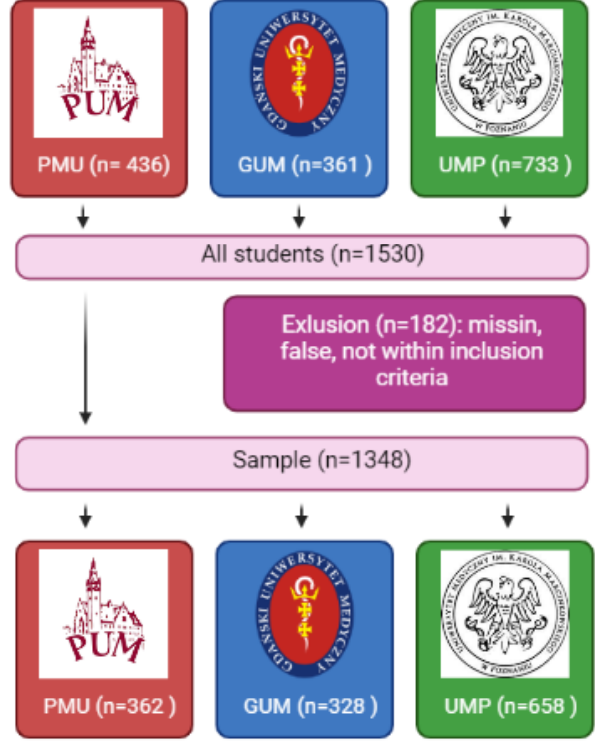
Figure 1. Selection of the study group.